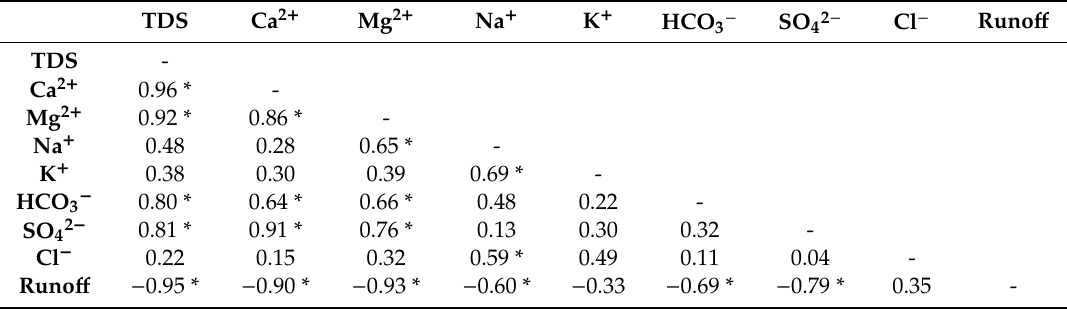
Table 5. Pearson correlations of major ions and runo ff in the